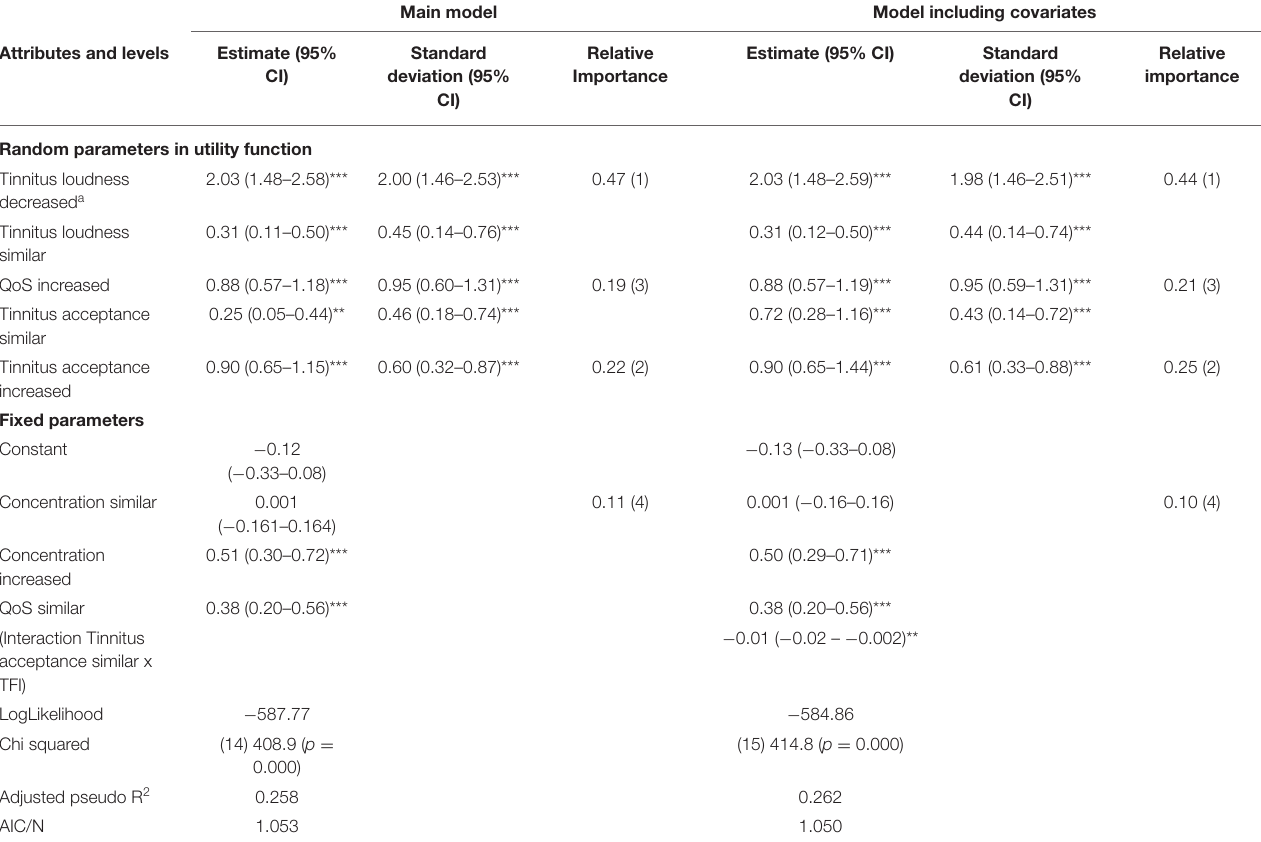
TABLE 4 | Result of the mixed effect model.